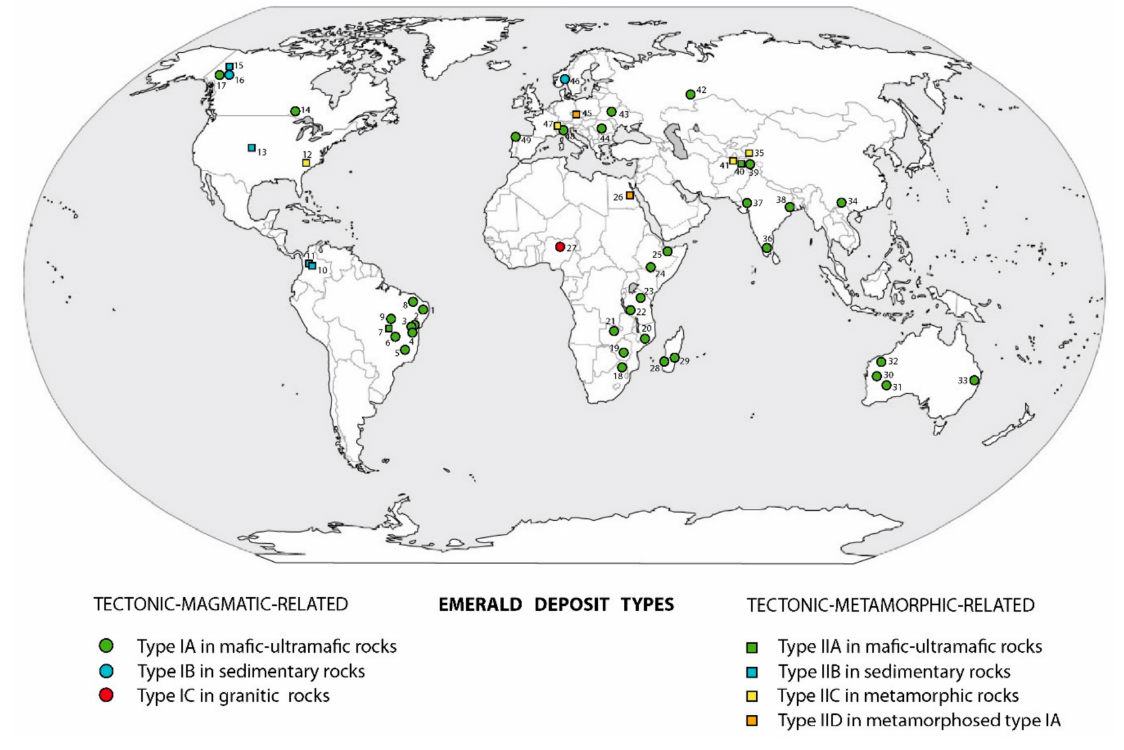
Figure 2. The location of emerald deposits and occurrences worldwide reported following their geological types, i.e., tectonic magmatic-related (type I) and tectonic metamorphic-related (type II): Brazil : 1. Fazenda Bonfim; 2. Socot ó ; 3. Carna í ba; 4. Anag é , Brumado; 5. Piteiras, Belmont mine, Capoierana, Santana dos Ferros; 6. Piren ó polis, Itaberai; 7. Santa Terezinha de Goi á s; 8. Tau á , Coqui; 9. Monte Santo. Colombia : 10. Eastern emerald zone (Gachal á , Chivor, Macanal); 11. Western emerald zone (Yacop í , Muzo, Coscuez, Maripi, Cunas, La Pita, La Marina, Peñas Blancas). United States : 12. Hiddenite; 13. Uinta. Canada : 14. Dryden; 15. Mountain River; 16: Lened; 17. Tsa da Gliza. South Africa : 18. Gravelotte. Zimbabwe : 19. Sandawana, Masvingo, Filibusi. Mozambique : 20. Morrua. Zambia : 21. Kafubu, Musakashi. Tanzania : 22. Sumbawanga; 23. Manyara. Ethiopia: 24. Kenticha (Halo-Shakiso). Somalia : 25. Boorama. Egypt : 26. Gebels Sikaït, Zabara, Wadi Umm Kabu. Nigeria: 27. Kaduna. Madagascar : 28. Ianapera; 29. Mananjary. Australia : 30. Poona; 31. Menzies; 32. Wodgina; 33. Emmaville, Torrington. China: 34. Dyaku; 35. Davdar. India: 36. Sankari Taluka; 37. Rajasthan (Bubani, Rajgarh, Kaliguman); 38: Gubaranda (Orissa state). Pakistan : 39: Khaltaro; 40. Swat valley. Afghanistan : 41. Panjshir valley. Russia: 42. Urals (Malyshevo). Ukraine : 43. Wolodarsk. Bulgaria : 44. Rila. Austria : 45. Habachtal. Norway : 46. Eidswoll. Switzerland : 47. Binntal. Italia : 48. Val Vigezzo. Spain : 49. Franqueira.